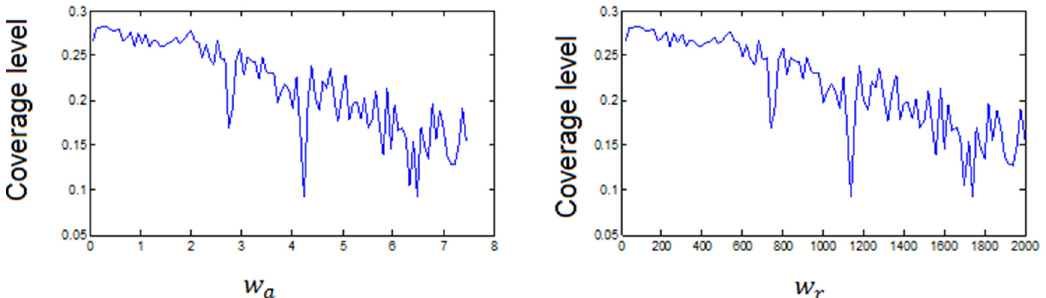
Figure 8. Coverage level achieved for different settings of w a and w r . The number of nodes = 20, D th = 20, and area size = 150 ˆ 150